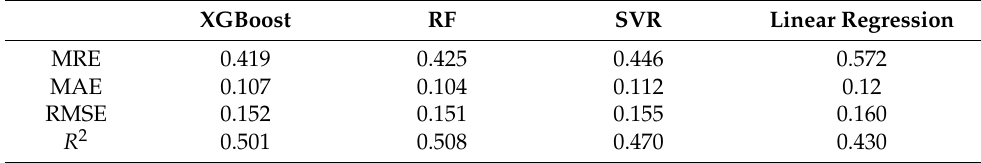
Table 6. Six environmental factors used for modeling.